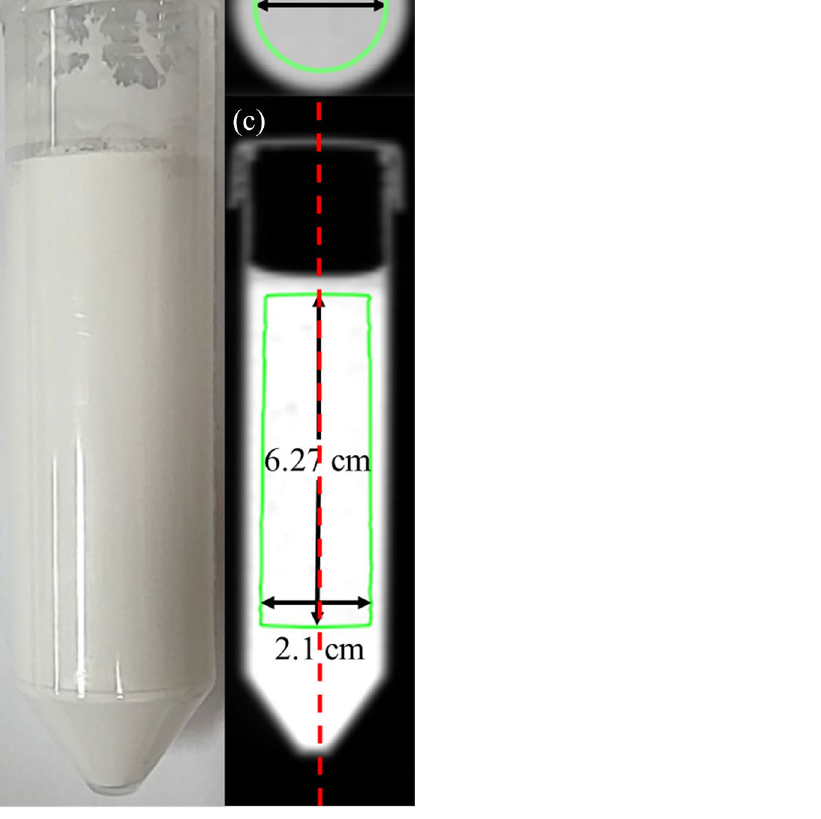
Figure 4. ( a ) Photograph of the mixture of plaster and PLA power. ( b ) Transversal and ( c ) frontal CT images of the samples.